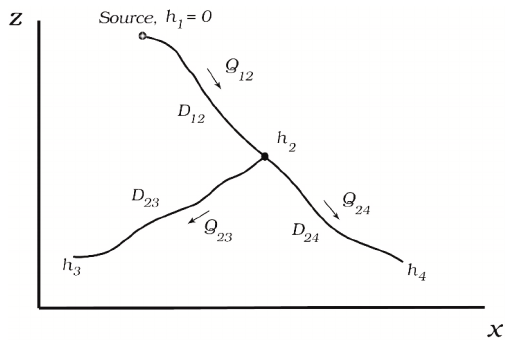
Figure 2. Three-pipe branch